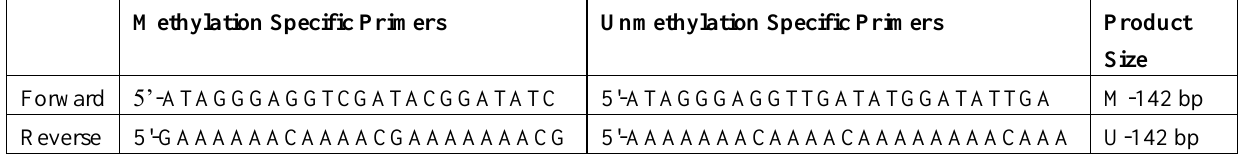
Figure 3. Aberrant methylation of NIS detected by methylation-specific PCR (MSP). Lanes 1 and 2: universal methylated and unmethylated controls. Lanes 3-14 span biopsies for Cases 3, 4 and 13. Note presence of methylated product in lanes 3, 7 and 9.